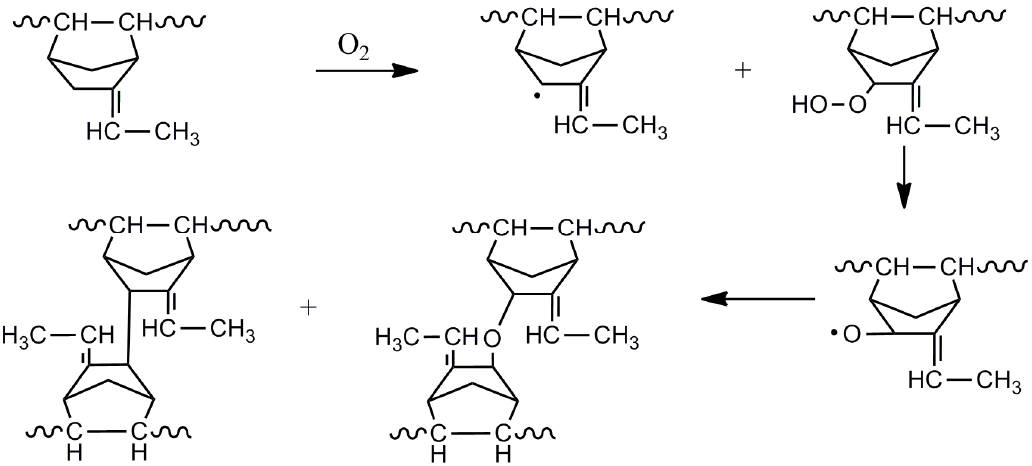
Figure 4. Thermo-oxidative aging mechanism for EPDM.